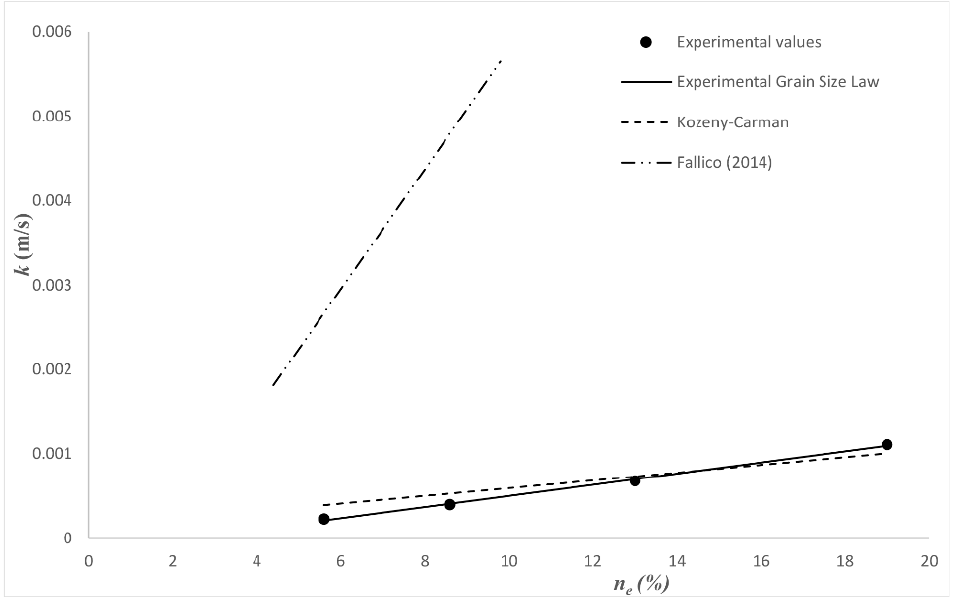
Figure 8. Comparison between the representation of the global scaling law, explicated by the [40] model and using the [19,20] model.